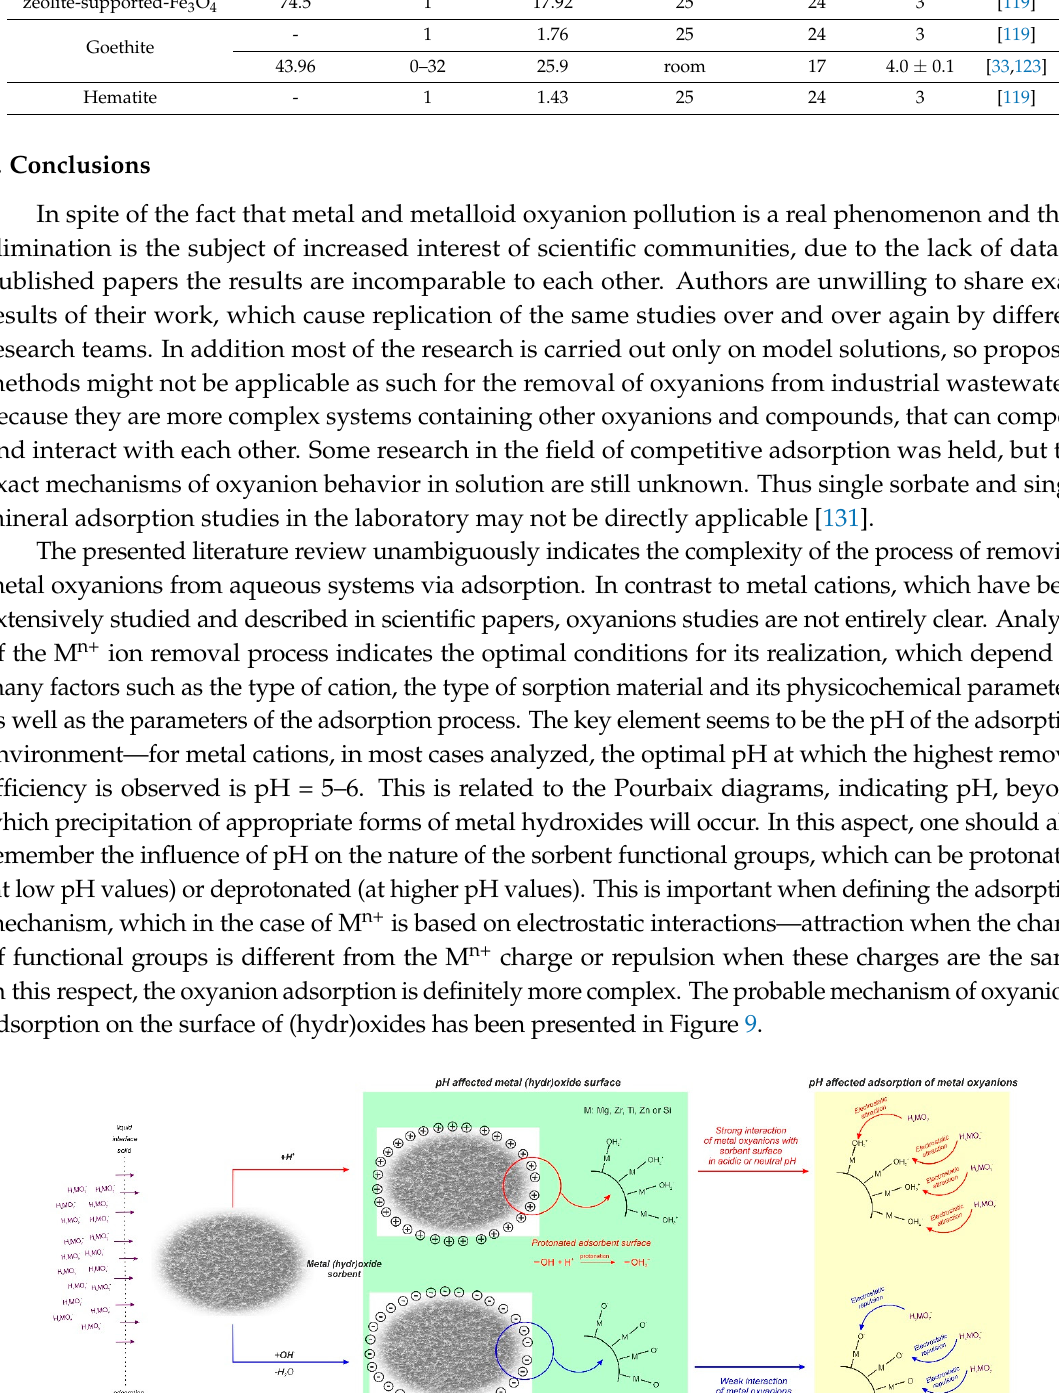
Figure 10. Bar chart of the number of articles per year about oxyanions adsorption for the 1989–28 January 2019. The statistical data was obtained by searching “adsorption metal oxide arsenite and arsenate/vanadate/borate/tungstate/molybdate” in the Scopus data base as title and keywords. The environment pH influences as well metal chemistry in solution (occurrence of various oxyforms) as the metal (hydr)oxide surface’s protonation/deprotonation [68]. Thus in most cases it is the determining factor of adsorption effectiveness, but unfortunately for research results it is neglected. The spectrum of speciation forms of oxyanions of the relevant metal is very wide, which translates into their random behavior in aqueous solutions, especially those with varying pH. Unfortunately, the aspect of the effect of pH on the efficiency of oxyanion-binding by various sorbents, e.g., those presented in the literature review, is treated fairly generally, and in some cases even overlooked. This hinders the interpretation of the dependencies obtained and introduces confusion regarding the comparison of the behavior of various sorption materials towards the removal of these types of impurities from aqueous solutions. The presented comparisons unequivocally do not indicate optimal conditions for the removal of a particular oxyanion group using the available sorption materials. It seems that the mechanism of their binding should be at least similar for different sorbents, and as a result it is completely random. Analyzing at least the effect of 0 50100150200 250 300 N u m b e r o f p a p e r s